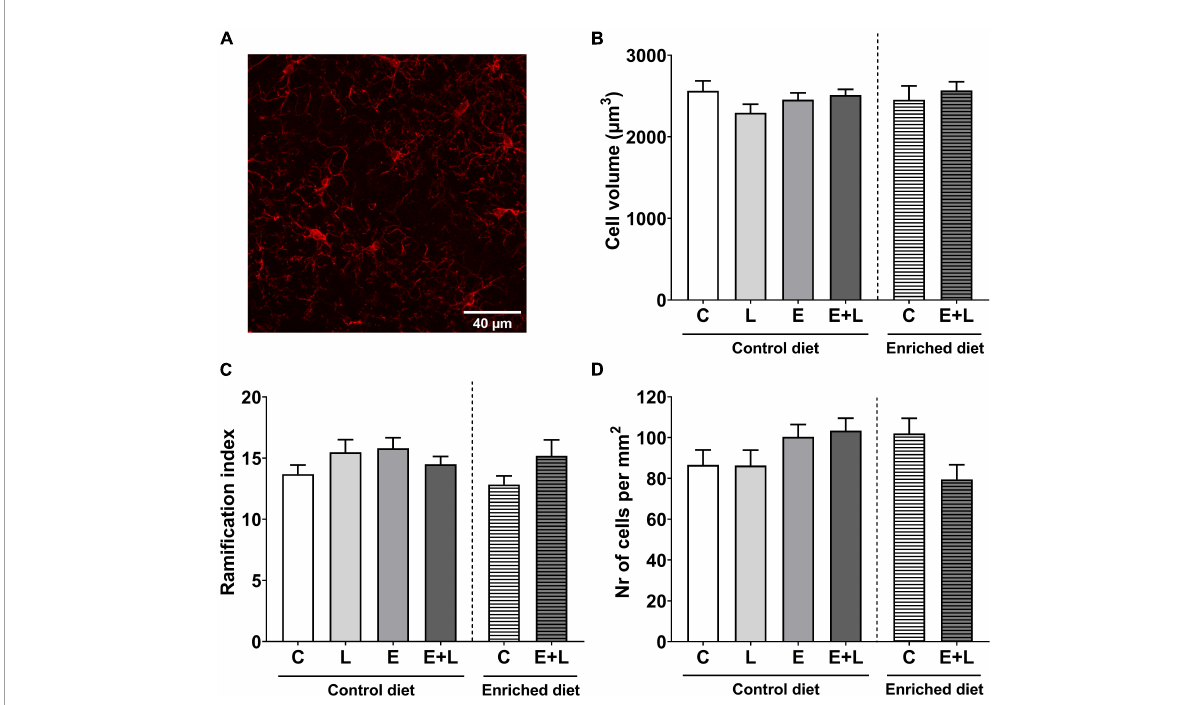
FIGURE10 Microglia parameters in the CA1 region of the hippocampus. A 2D representation of a z-stack from the hippocampus in the control group stained with anti-iba1 (AlexaFluor 647) is presented in panel (A) . Total cell volume (B) , ramification index (C) , and the number of cells per mm 2 (D) have been assessed. Data are presented as mean ± SEM ( n = 6 per group). C, control; L, LPS; E, elastase; E + L, elastase plus